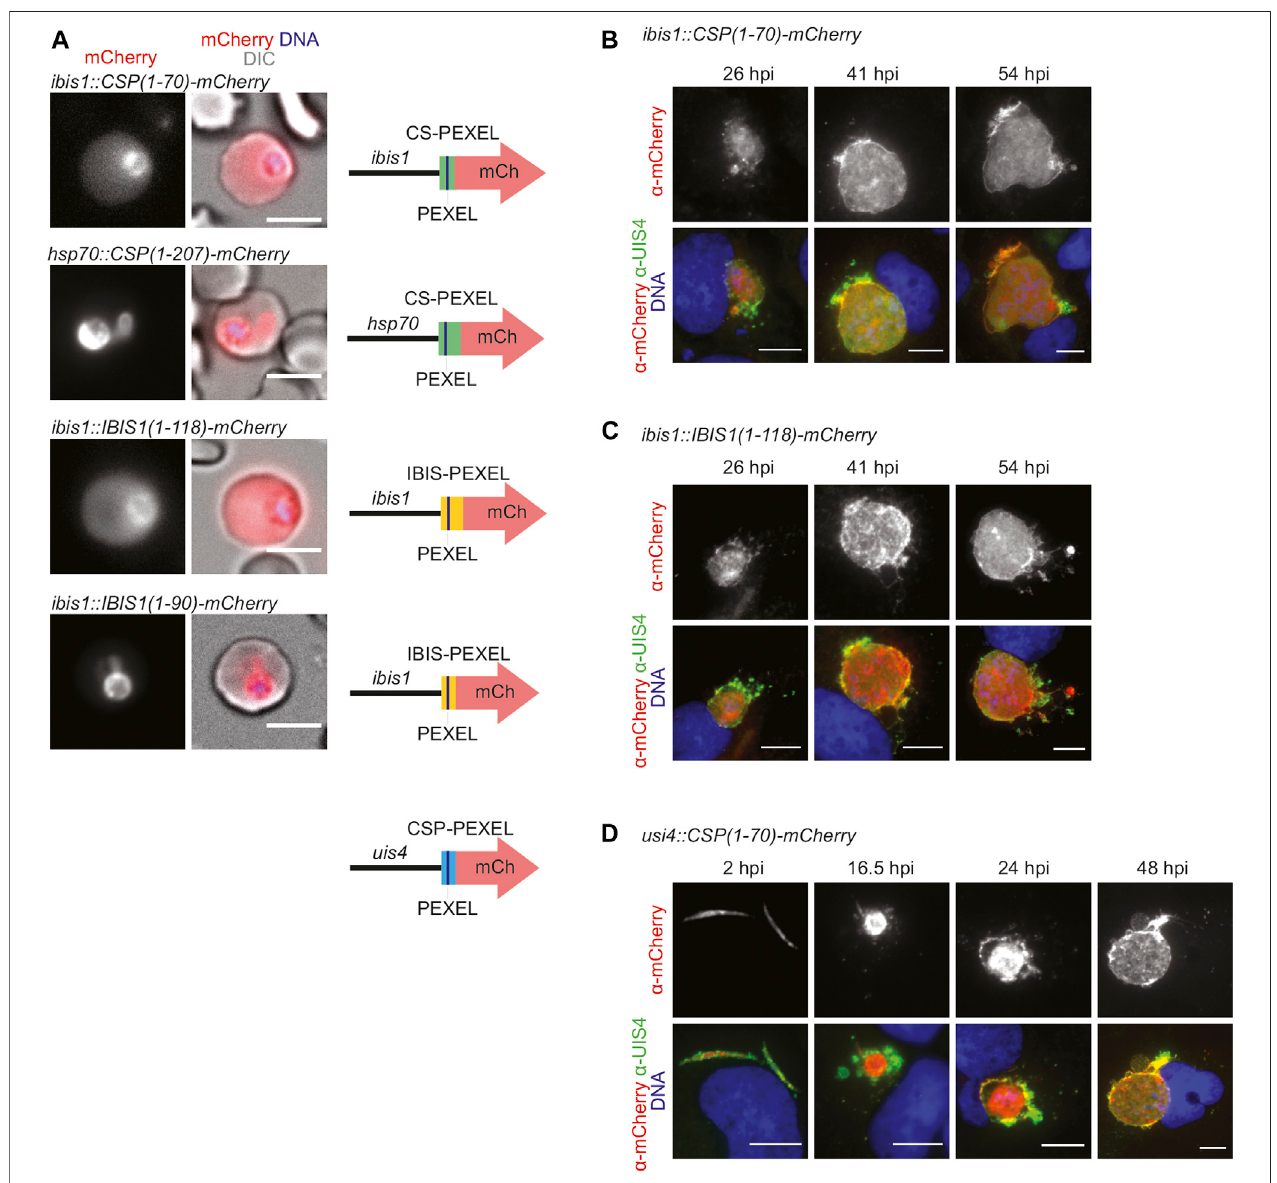
FIGURE 1 | PEXEL-dependent export of mCherry reporter protein occurs during blood but not liver infection. (A) Live fl uorescence imaging of parasite-infected erythrocytes. Shown are the mCherry signal (left) , a merge with DIC images (center) , and graphic images of the reporter constructs (right). Depicted are promoters, PEXEL regions (green, yellow, blue), the PEXEL motif (line), and the mCherry open reading frame (red arrow). Top row, erythrocyte infected with a transgenic CSP 1-70 - mCherry parasite under the control ofthe IBIS1 promoter. Upper center row, erythrocyte infected witha transgenic CSP 1-70 -mCherry parasite under the control of the hsp70 promoter. Lower center row, erythrocyte infected with a transgenic IBIS 1-118 -mCherry parasite under the control of the IBIS1 promoter. Bottom row, erythrocyte infected with a transgenic IBIS 1-90 -mCherry parasite under the control of the IBIS1 promoter. Bar, 5 μ m. (B – D) Immuno fl uorescent staining of Huh7 cells infectedwiththeparasitelinesexpressingeither (B) CSP 1-70 -mCherry , (C) IBIS1 11-118 -mCherry ,or (D) CSP-PEXEL-mCherry underthecontrolofthepromoterindicated andattheindicatedtimepointsaftersporozoiteinfections.Shownare α -mCherrysignals (toprow) andmergeimages (bottomrow) of α -mCherry(red), α -UIS4(green), and Hoechst 33,342 (blue) stain. Bar, 10